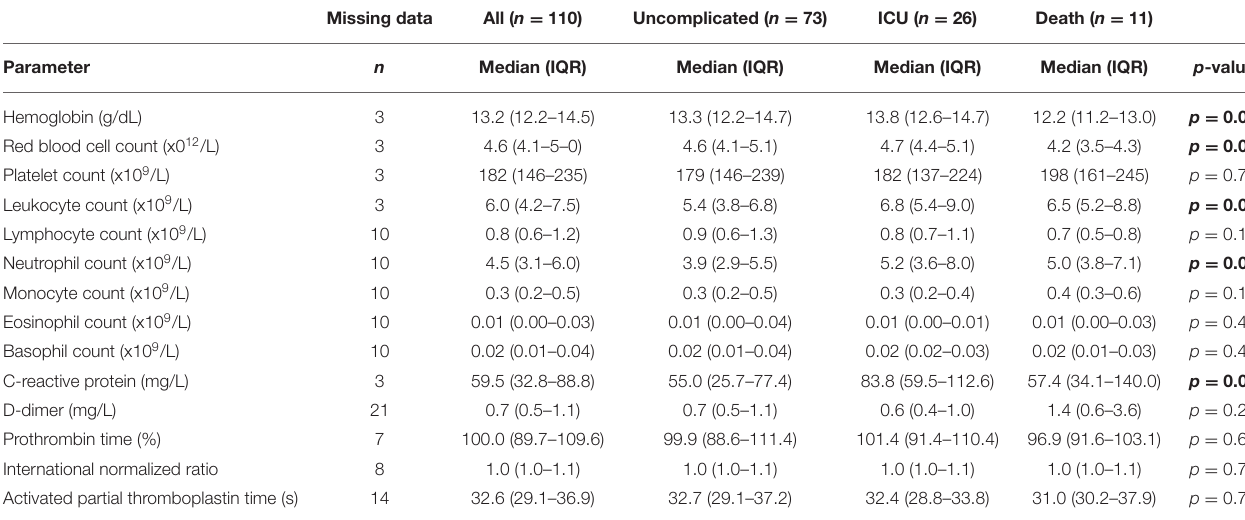
TABLE 2 | Laboratory findings at